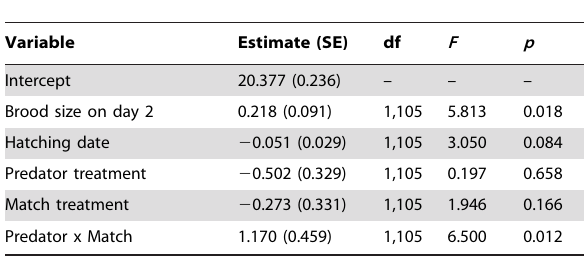
Table 2. ANOVA table for fledging